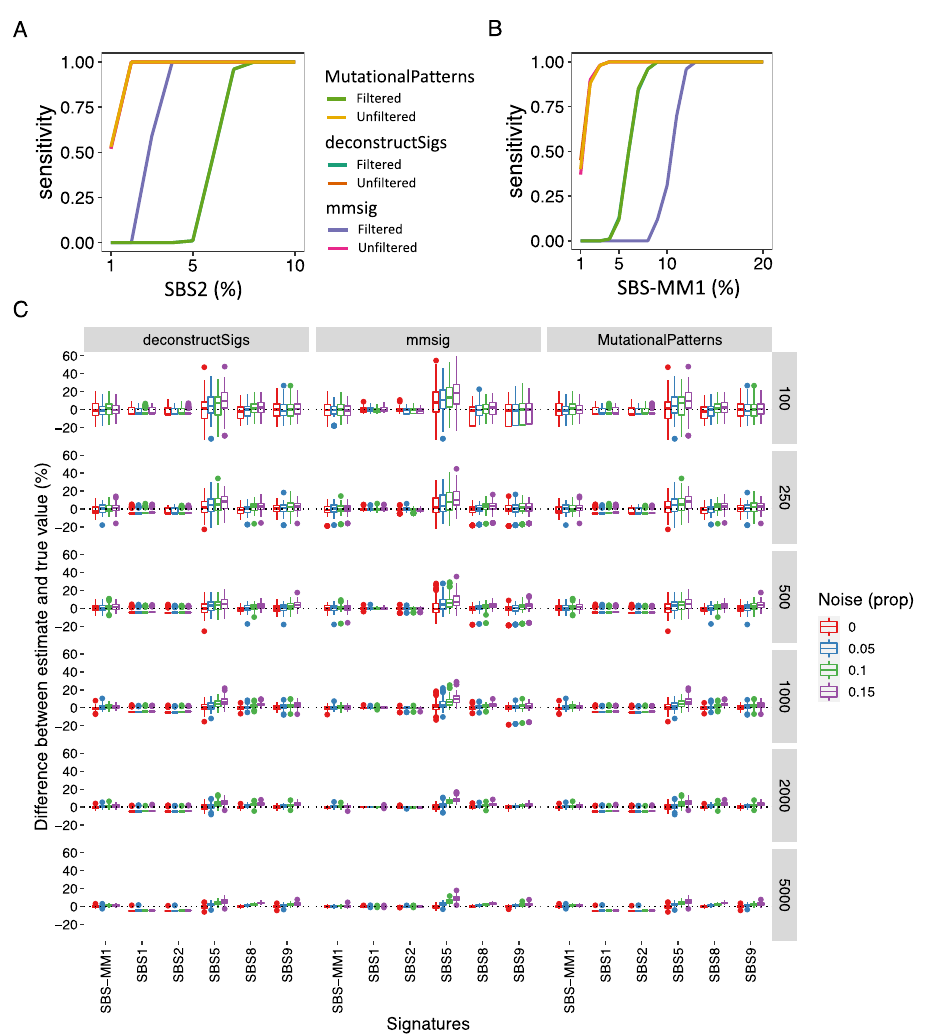
Fig. 6 Simulated multiple myeloma genomes. Mutational signature contributions were estimated for simulated mutational catalogs corresponding to average multiple myeloma (MM) genomes. A , B Dilution series of 1 – 10% SBS2 ( A ) and 1 – 20% SBS-MM1 ( B ) contribution in a background similar to an average MM genome. 100 simulations of 5000 mutations were performed at each dilution. Mutational signature fi tting was performed by mmsig, mutationalPatterns , and deconstructSigs without fi lters and using standard fi lters. The lines corresponding to the sensitivity without fi lters are superimposed for all three algorithms consistent with virtually identical results. Regarding the results after fi ltering, mutationalPatterns and deconstructSigs showed virtually identical performance, leading to the sensitivity curves being superimposed, whereas mmsig showed either higher ( A ) or lower ( B ) sentisitivity than the other algorithms. C 100 simulations were generated of 5000, 2000, 1000, 500, 250, and 100 mutations (rows) and mutational signature fi tting performed by mmsig, mutationalPatterns and deconstructSigs with standard fi lters (columns). Boxplots show median and interquartile range with outliers drawn as dots. Each data point represents the estimated signature contribution in one simulated mutation